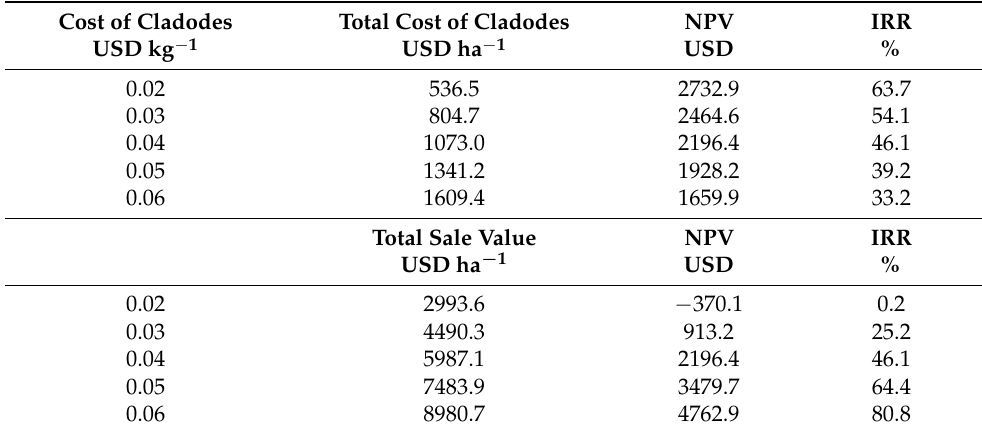
Table 13. Sensitivity of NPV and IRR for different costs of acquisition of cactus cladode seeds and sale of produced cladodes in the Brazilian Northeast production system.